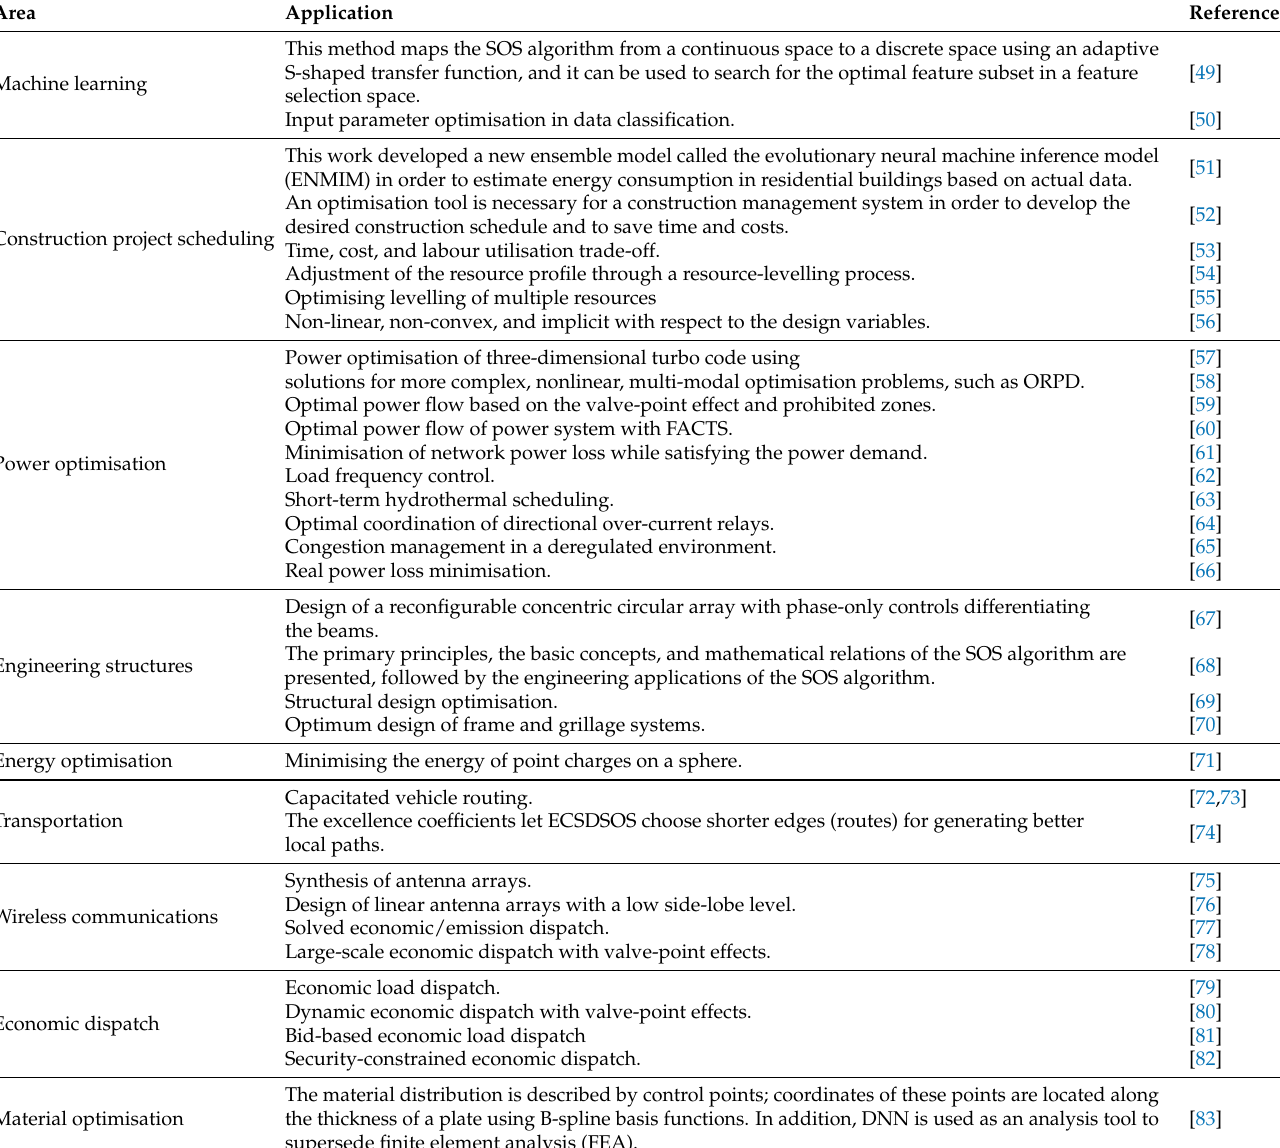
Table 1. Applications of SOS algorithms in different